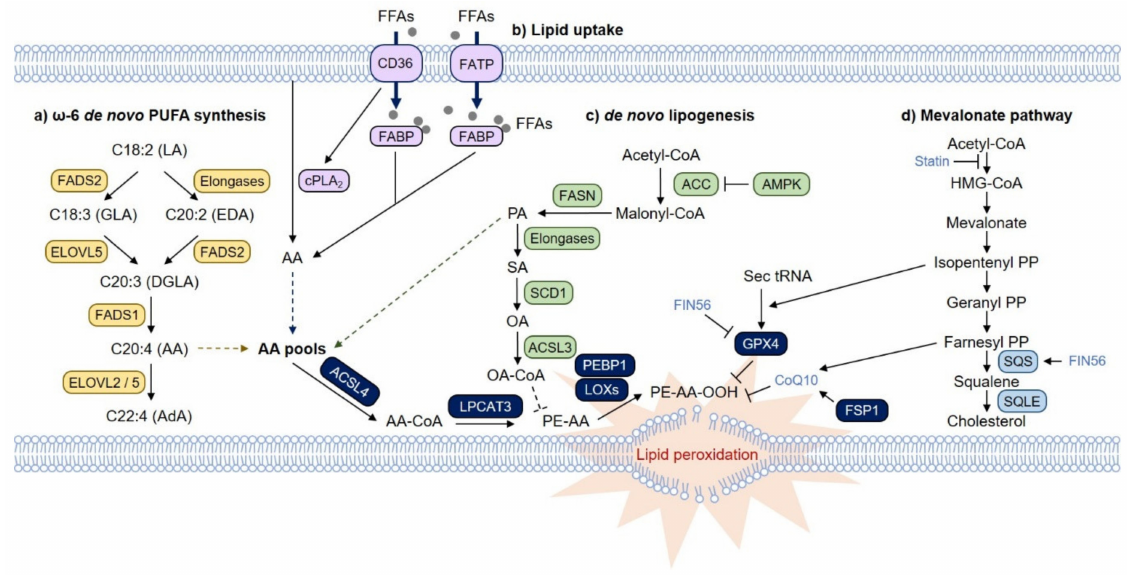
Figure 2. Lipid metabolic pathways that regulate ferroptosis. ( a ) In cells, PUFAs can accumulate through the ω -6 de novo PUFA biosynthesis pathway and fatty acid transport pathways via fatty acid translocase (FAT/CD36), fatty acid transport protein (FATP) and fatty acid binding protein (FABP). Imported linoleic acid (LA) is metabolized by elongation of very long-chain fatty acid protein (ELOVL) and fatty acid desaturases (FADS) to synthesize AA and AdA, which are utilized to produce membrane phospholipids. ( b ) Additionally, AA can be directly imported and transported by FAT/CD36, FATP and FABP proteins. In particular, CD36 activates cytoplasmic phospholipase A 2 (cPLA 2 ), releasing AA from phospholipids. The intracellular pools of AA might be the critical checkpoint in ferroptosis and AA-mediated cellular signaling. ( c ) In contrast, monounsaturated fatty acid (MUFA), which is catalyzed from palmitate, a saturated fatty acid (SFA) by stearyl- CoA desaturase-1 (SCD1), is incorporated into phospholipids in an ACSL3-dependent manner, thereby interfering with the formation of PUFA-phospholipids and protecting cells from ferroptosis. Under glucose deprivation conditions, the depletion of ATPs activate the AMP-activated protein kinase (AMPK) pathway, which suppresses de novo lipogenesis by phosphorylating and inhibiting acetyl-CoA carboxylase (ACC). As a result, the levels of not only palmitate but also dihomo- γ -linolenic acid (DGLA) and AA are reduced upon glucose starvation, preventing ferroptosis. ( d ) The mevalonate pathway also provides several critical regulatory axes. Isopentenyl pyrophosphate (IPP) is required for the isopentenylation of selenocysteine-tRNA, leading to the synthesis of selenoproteins, including GPX4. Inhibition of HMG-CoA reductase (HMGCR) by statins might induce ferroptosis by inactivating GPX4. FIN56, a class III FIN, degrades GPX4 and activates squalene synthase (SQS). Activation of SQS results in the squalene depletion of coenzyme Q10 (CoQ10), contributing